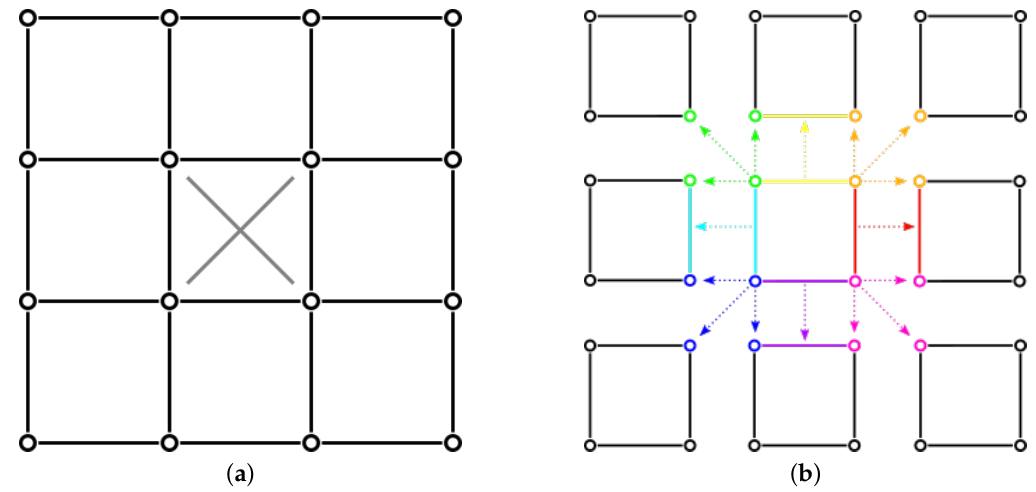
Figure 6. Summary of the relations to preserve for neighboring tiles. In ( a ), we depict a regular grid representing the eight neighboring tiles of the center tile, marked with a grey cross, which we are processing. We mark the corners of the tile with a circle and the rest of coincident vertices at the borders with a straight line. In ( b ) we space out the tiles, to emphasize that each one has to be processed separately. Note that, when the central tile finishes processing, the corners are transferred to the adjacent three tiles, while the borders are transferred to just one neighboring